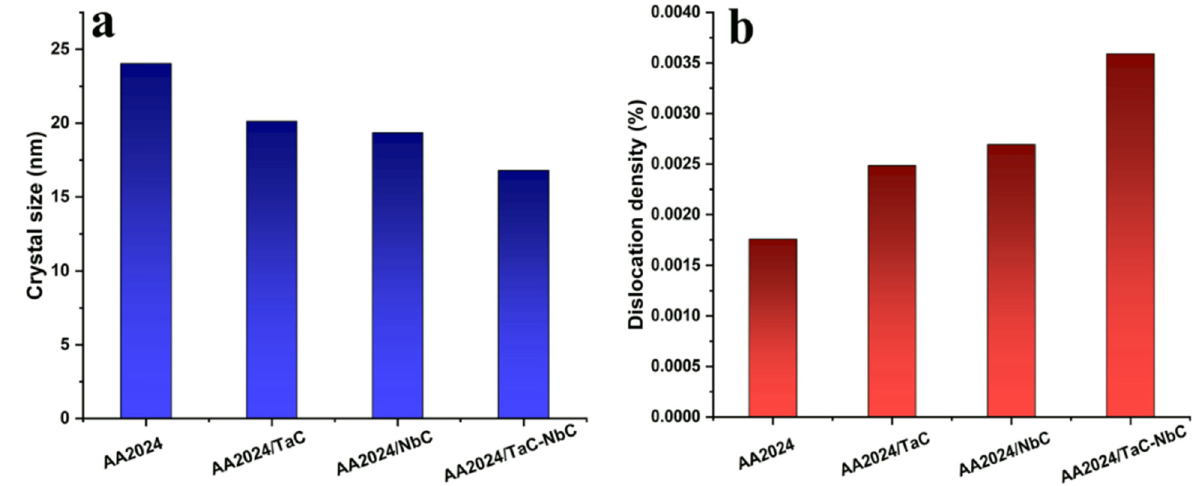
Figure 9: E ff ect of ceramic reinforcement on ( a ) crystal size and ( b ) dislocation density.